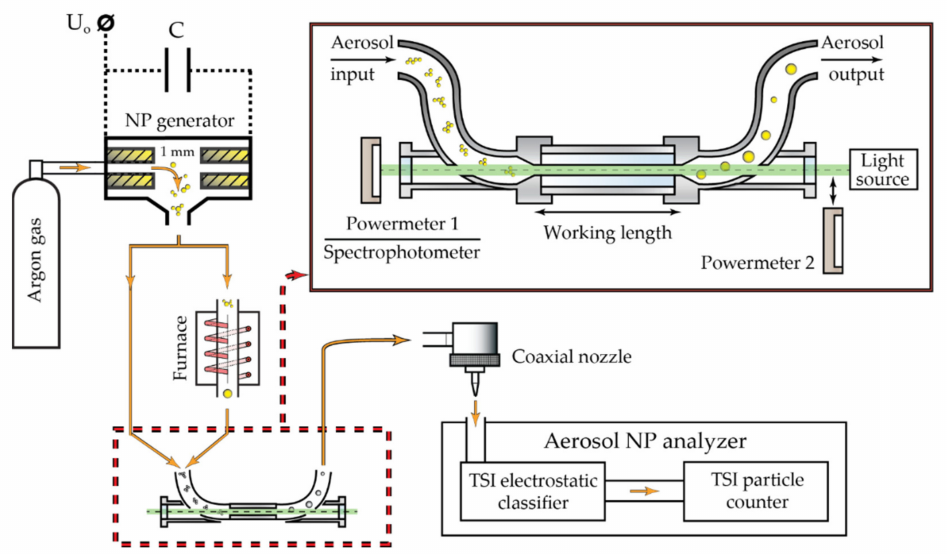
Figure 1. The scheme of the experimental setup: the insert shows a schematic image of the cell combining an aerosol stream and optical radiation, which can optionally be laser radiation or white